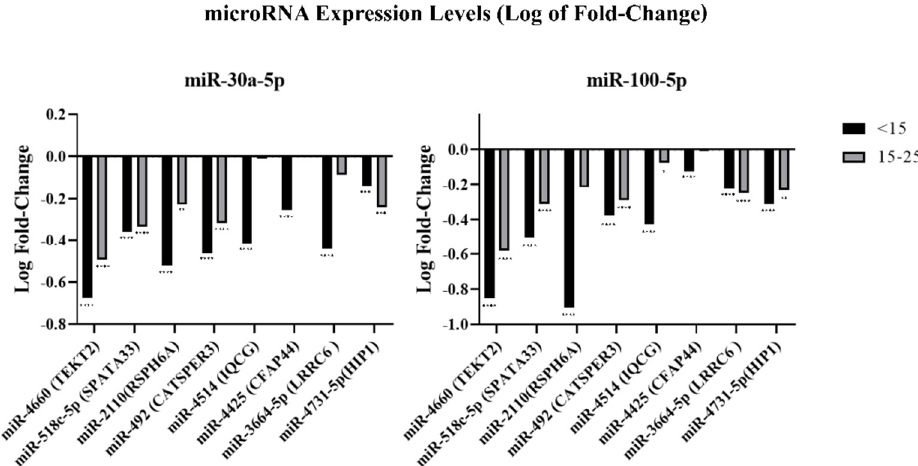
Figure 4. Log of fold change of the miRNA expression levels in spermatozoa from patients with RPM < 15% and RPM between 15–25%. Statistical significance was determined using the Kruskal– Wallis test, with α < 0.05. * p < 0.05, ** p < 0.01, *** p < 0.001 and **** p < 0.0001. miR-30a-5p ( left ) and miR-100-5p ( right ) were used as reference genes.